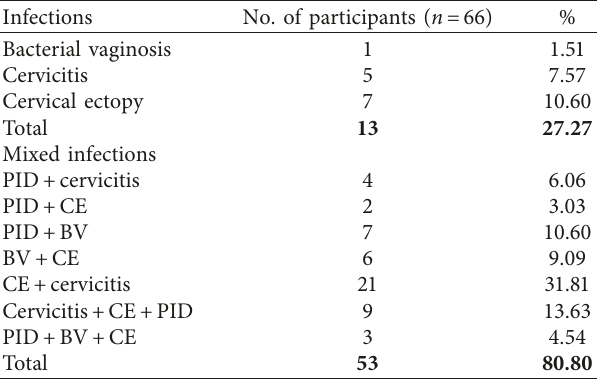
Table 1: Prevalence of infections alone and/or mixed infections.